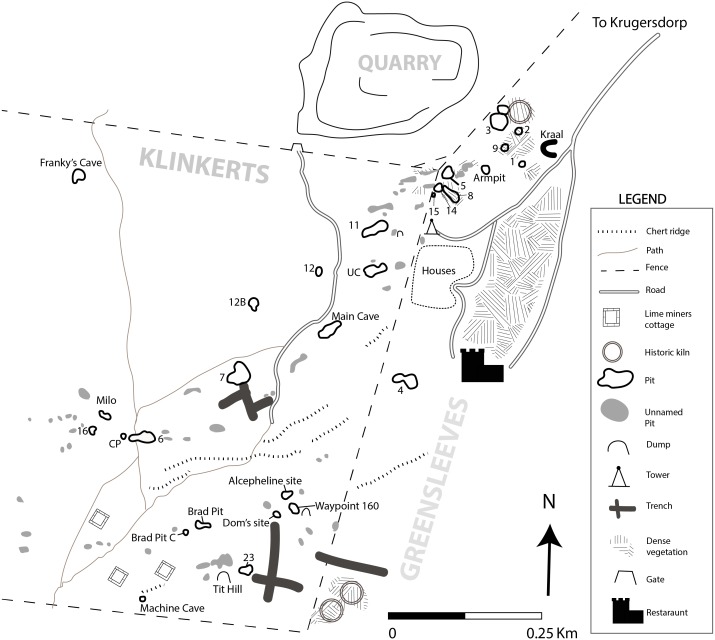
New georectified map of Bolt’s Farm from accurate DGPS survey.Coordinate system WGS1984 UTM35S.